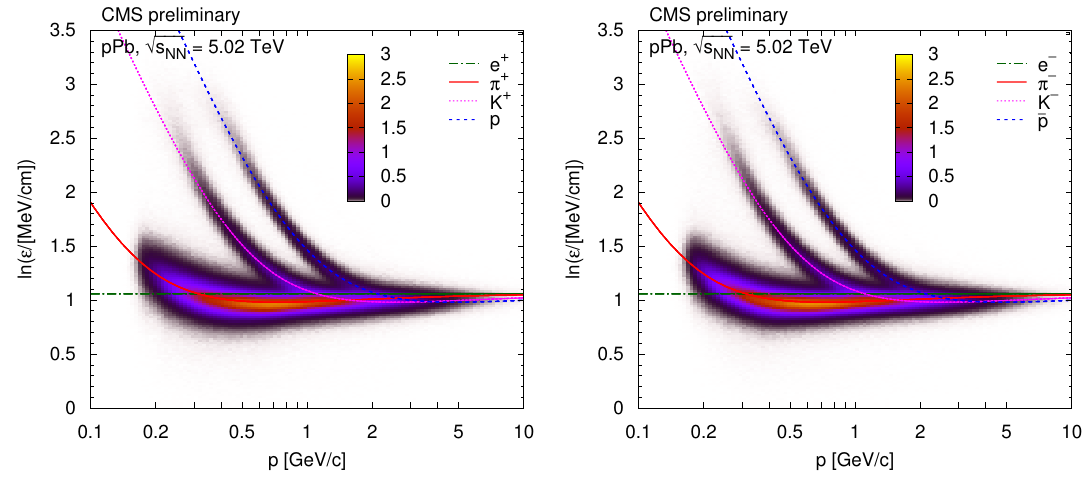
Figure 1. The distribution of ln ε as a function of total momentum p , for positively ( Left ) and negatively ( Right ) charged particles, in case of pPb collisions at energy loss rate at a reference path length l 0 = 450 µ m. The z scale is shown in arbitrary units and is linear. The curves show the expected ln ε for electrons, pions, kaons, and protons (full theoretical calculation, Equation (30.11) in Ref.